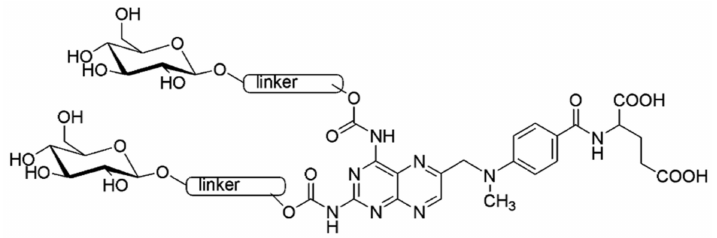
Figure 1. Structure of the MTX glycoconjugate (methotrexate glycoconjugate). The sugar unit occurring in the most thermodynamically stable 4 C 1 conformation is connected by the β - O -glycosyl bond with the spacer because, as is evident from the literature studies, such an orientation is preferred by the GLUT-1 transporting